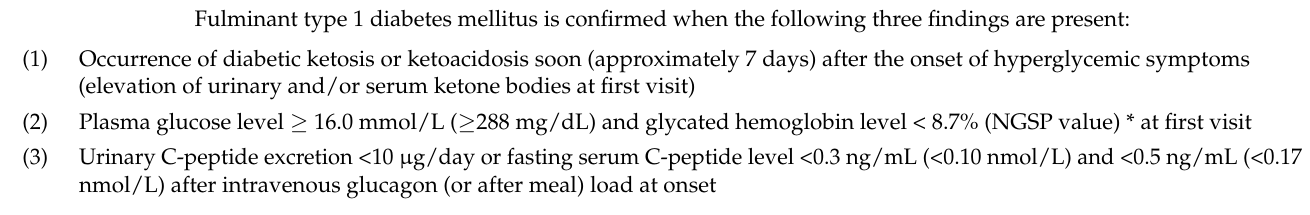
Table 2. Japanese criteria for definite diagnosis of fulminant type 1 diabetes mellitus (2012)